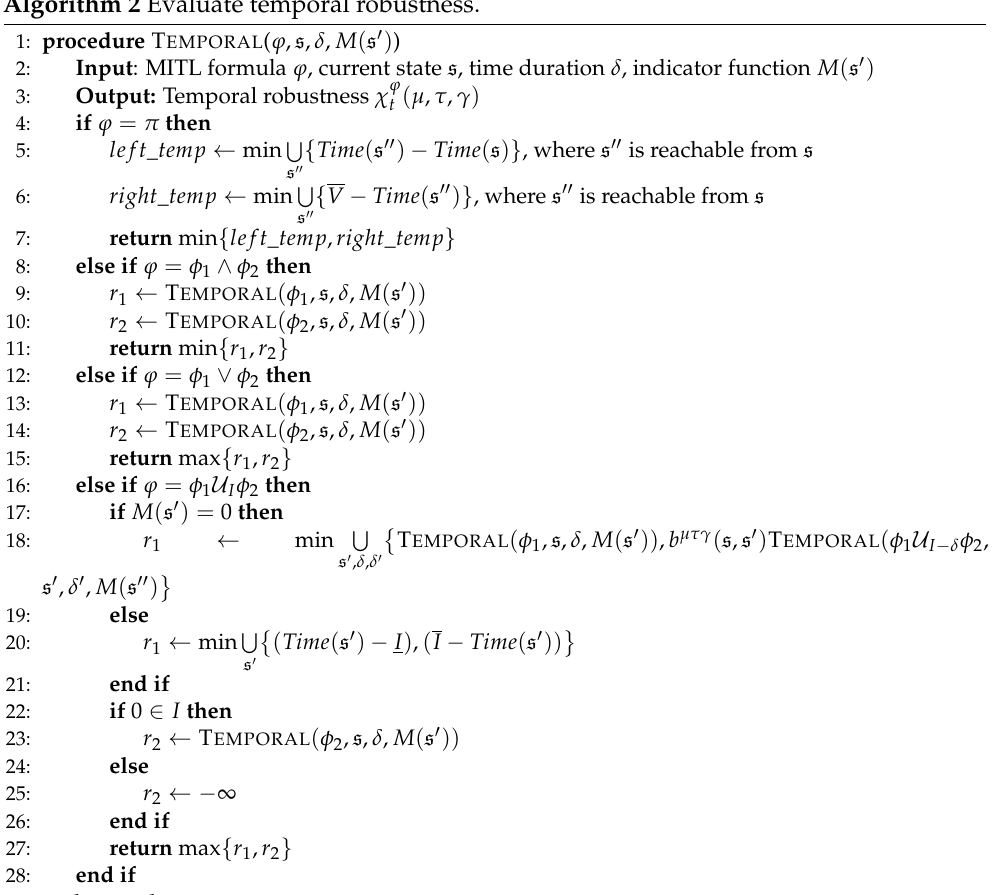
Algorithm 2 Evaluate temporal